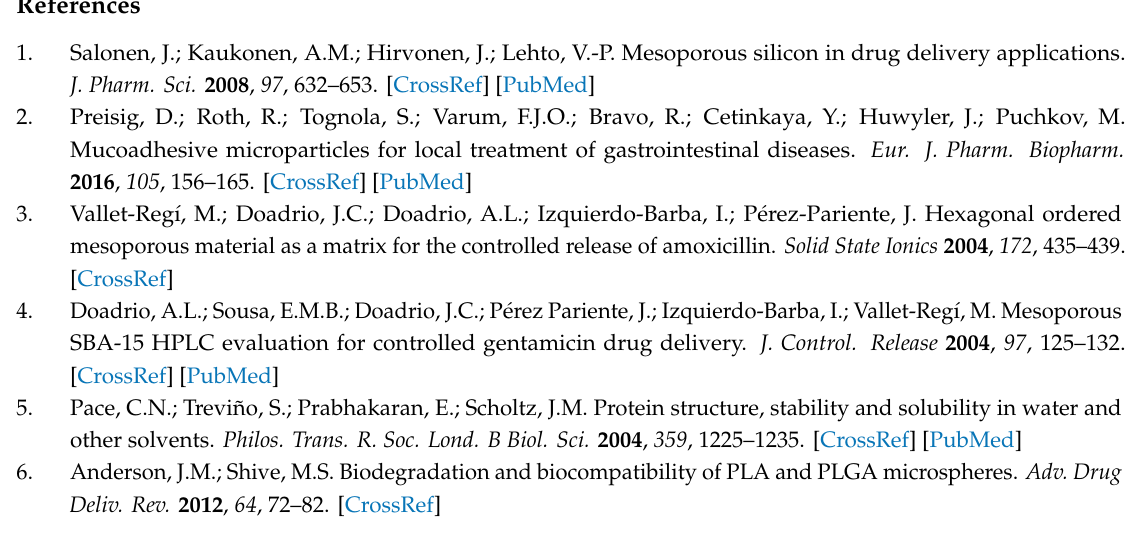
Figure S1: Thermogravimetric results of pure FCC, BSA, DPPC, and the final